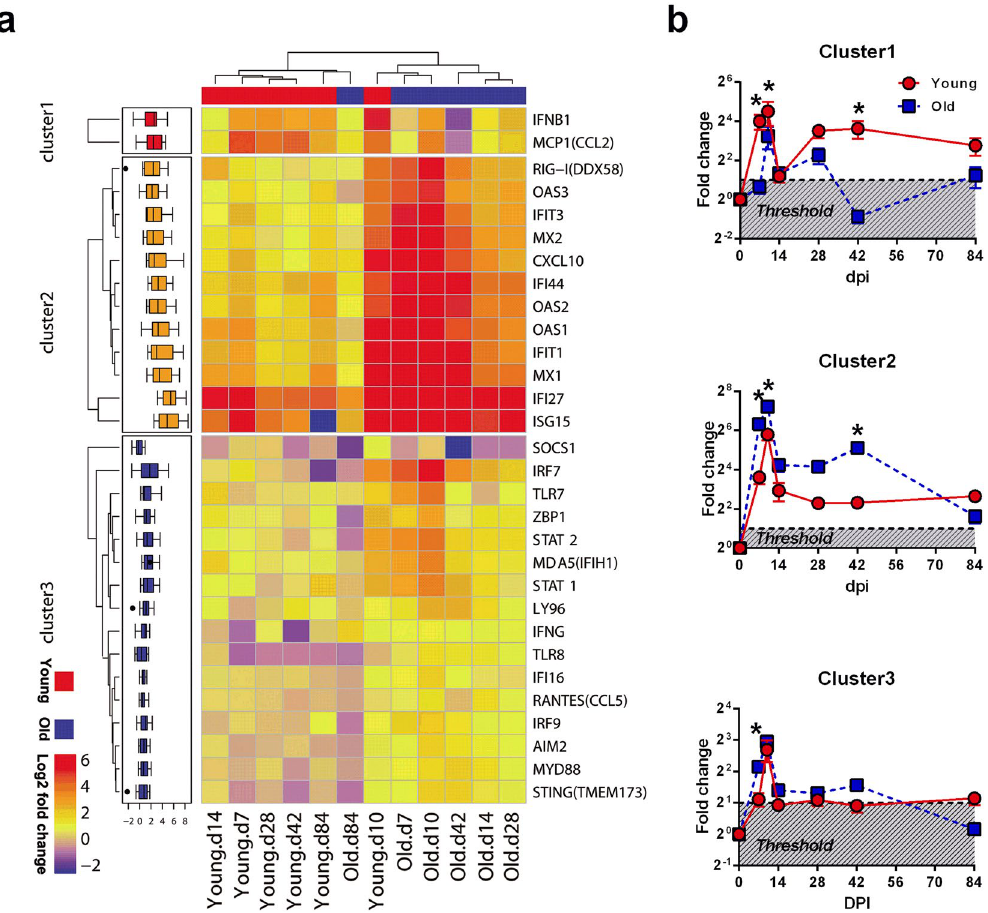
Figure 6. Acute SIV infection induces a robust innate host response in old ChRM. ( a ) Hierarchical clustering of 30 genes significantly induced by SIV infection (dpi = 0, 7, 10, 14, 28, 42 and 84) and differentially expressed between the young (n = 6) and old (n = 6) ChRM. Clustering was performed on the average of log2 ratios of mRNA expression relative to levels before infection by the RT-PCR-based ΔΔ Ct method. The genes were clustered on the basis of their expression value across samples using Euclidean distance and k-mean clustering. The progressive increases in mean log2-fold-change are represented by blue to red colors. ( b ) Graphs that display the characteristics of the three distinct clusters revealed in the left heat map. The threshold represents the credible induction by SIV infection for more than a 2-fold up-regulation of gene expression. The data are shown as the mean ± SEM. * P < 0.05 between the young (red circle) and old (blue square) groups, as determined by uncorrected Fisher’s LSD test post two-way